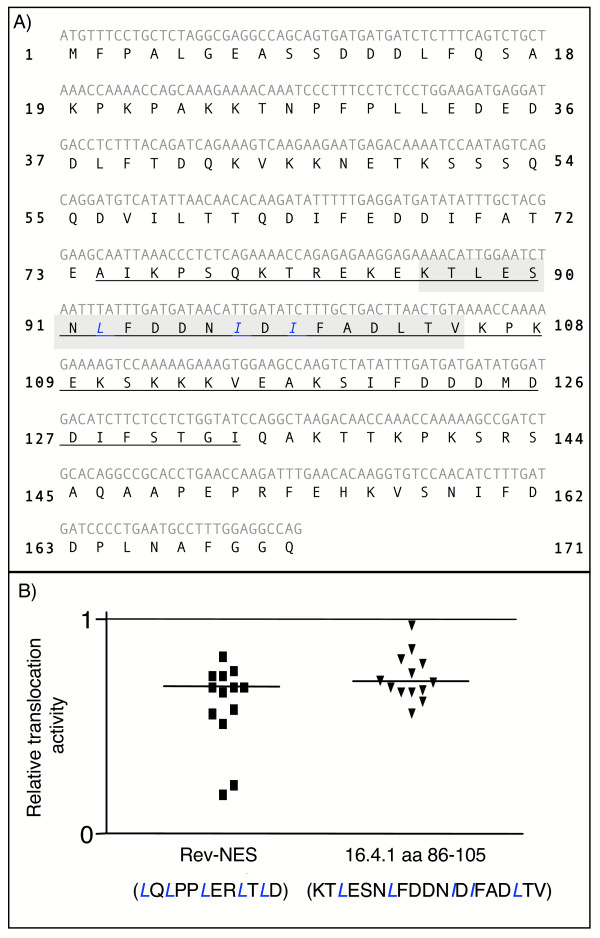
Functional analysis of a nuclear export signal in 16.4.1. (A) Depicted is the sequence (nucleotides and predicted amino acids) of the 16.4.1 protein investigated here. The sequence encoding amino acids 1–8 are derived from the fetal heart cDNA W67699. The region between amino acid residue 74 and 133 showing CRM1-dependent nuclear export activity (Fig. 4) is underscored. The amino acid sequence between residues 86 and 105 (shaded in grey) contains several Leucine and Isoleucine residues representing a candidate nuclear export signal. (B) Functional characterisation of the Leucine-Isoleucine rich sequence of 16.4.1. Comparison of the translocation activities of 16.4.1 region 86–105 and the Rev-NES in a microinjection-based transport assay [51]. Transport substrates were generated by conjugating peptides containing region 86–105 of 16.4.1 or region 73–84 of Rev with bovine serum albumin (BSA) labeled with a red fluorescent dye. Transport substrates were coinjected into the nucleus with an injection control consisting of unconjugated BSA labeled with a different fluorescent dye (e.g. green). The proportion of each fluorescent label in the nucleus of the injected cell was determined and the ratio of fluorescence of the transport substrate to fluorescence of the injection control calculated. This ratio represents the relative translocation activity of the transport substrate and is indicated in the graph. Nuclear export activity yields ratios <1 as demonstrated for the Rev NES. Transport substrates containing amino acid region 86–105 of 16.4.1 also yielded a relative translocation activity <1, indicating that this region of 16.4.1 can function as a nuclear export signal.